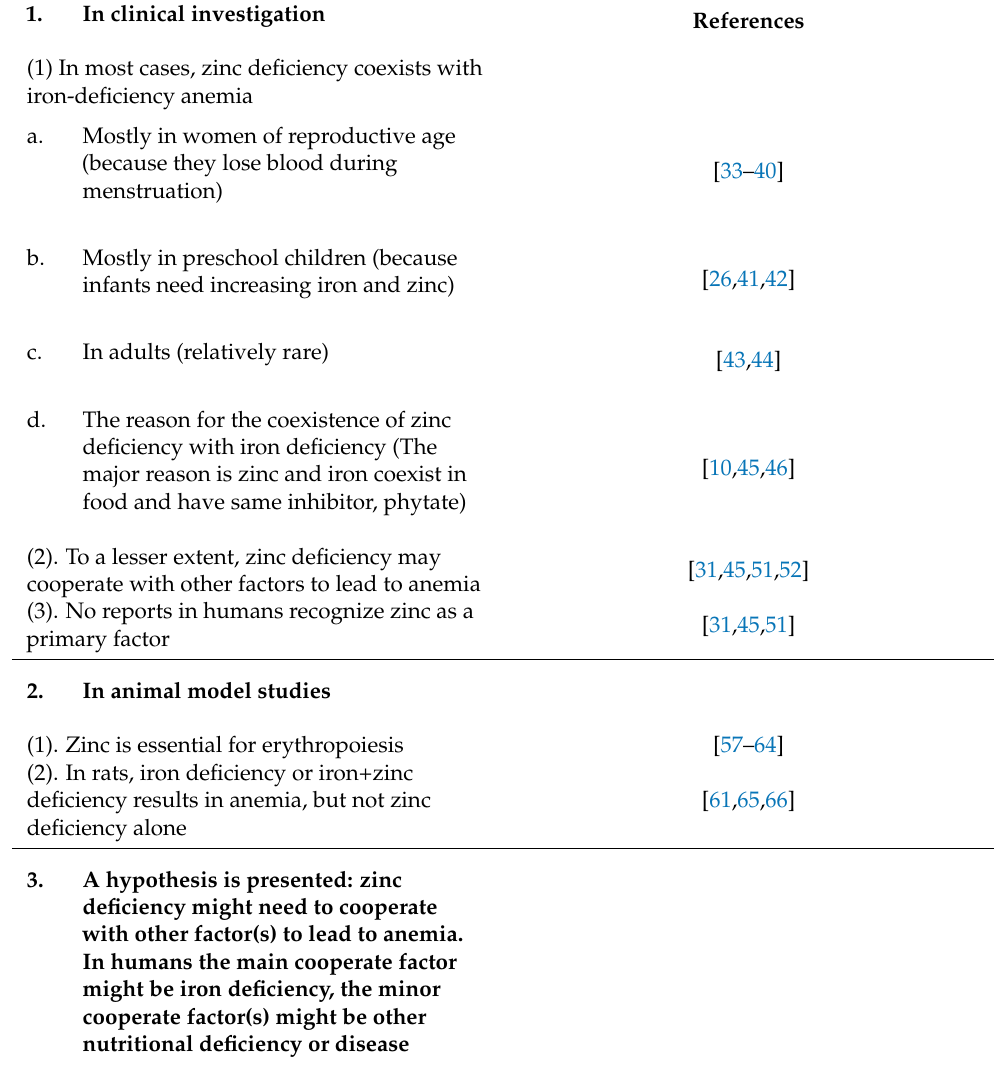
Table 1. Zinc deficiency contributing to